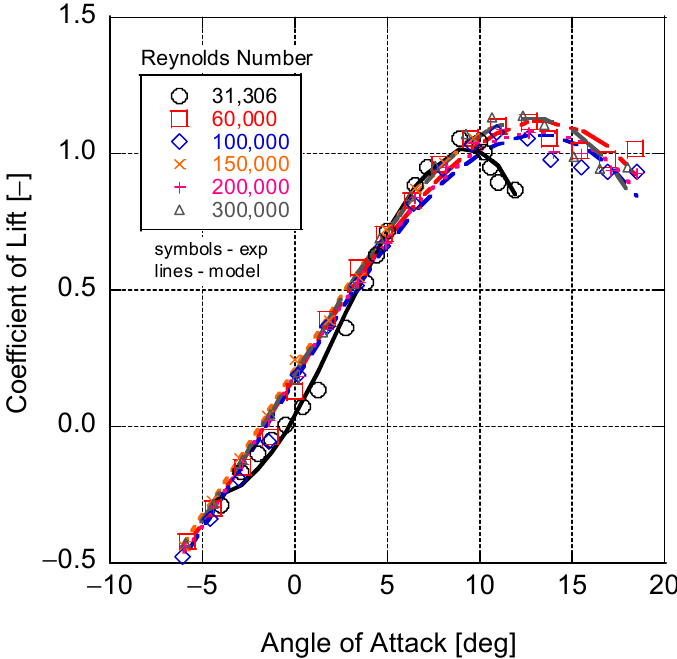
Figure 6. Use of K–J Theorem to match C l as a function of AoA at each Re number.